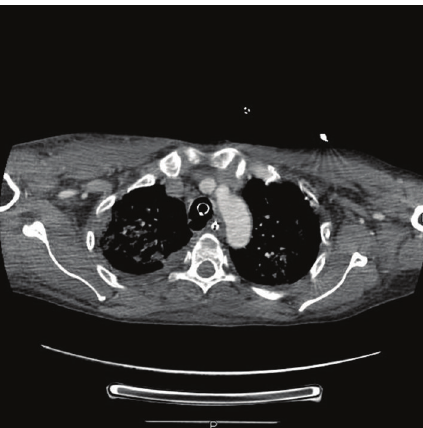
Figure 1: X-ray chest AP view showing endotracheal tube in the right mainstem carina.